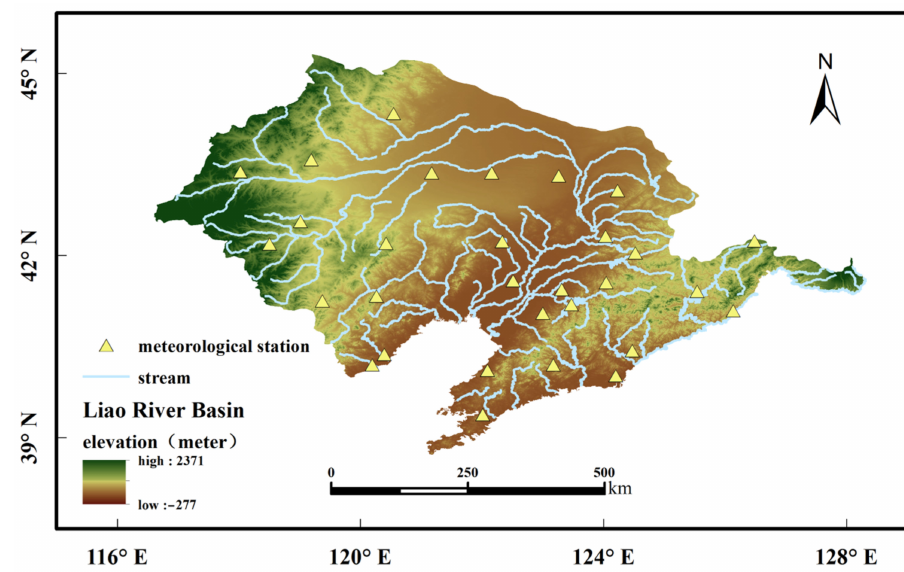
Figure 1. Map of meteorological station distribution in